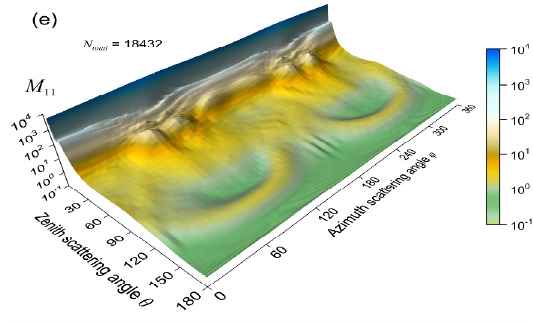
Figure 3. The first element of the Mueller matrix at the partial averaging over particle orientations for different numbers of orientation.